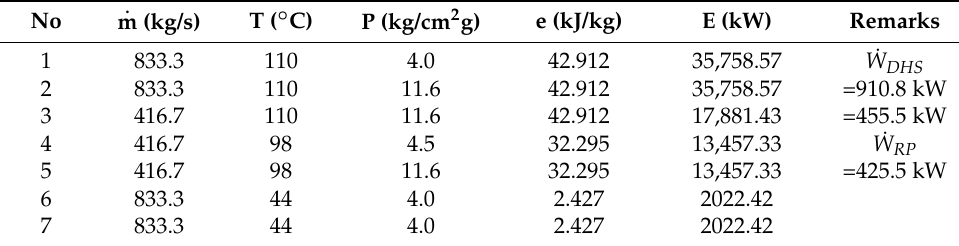
Table 5. Exergy value calculation results for each flow of heat storage system.